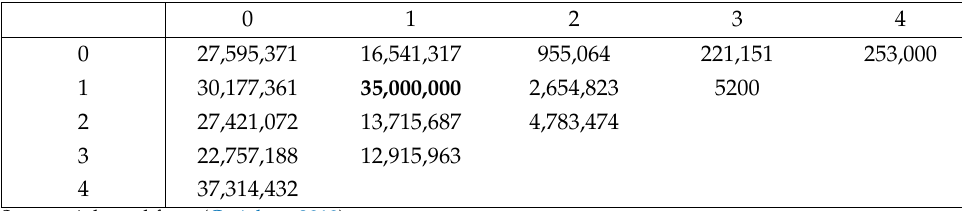
Table 10. Non-cumulative payments with an artificial outlier.